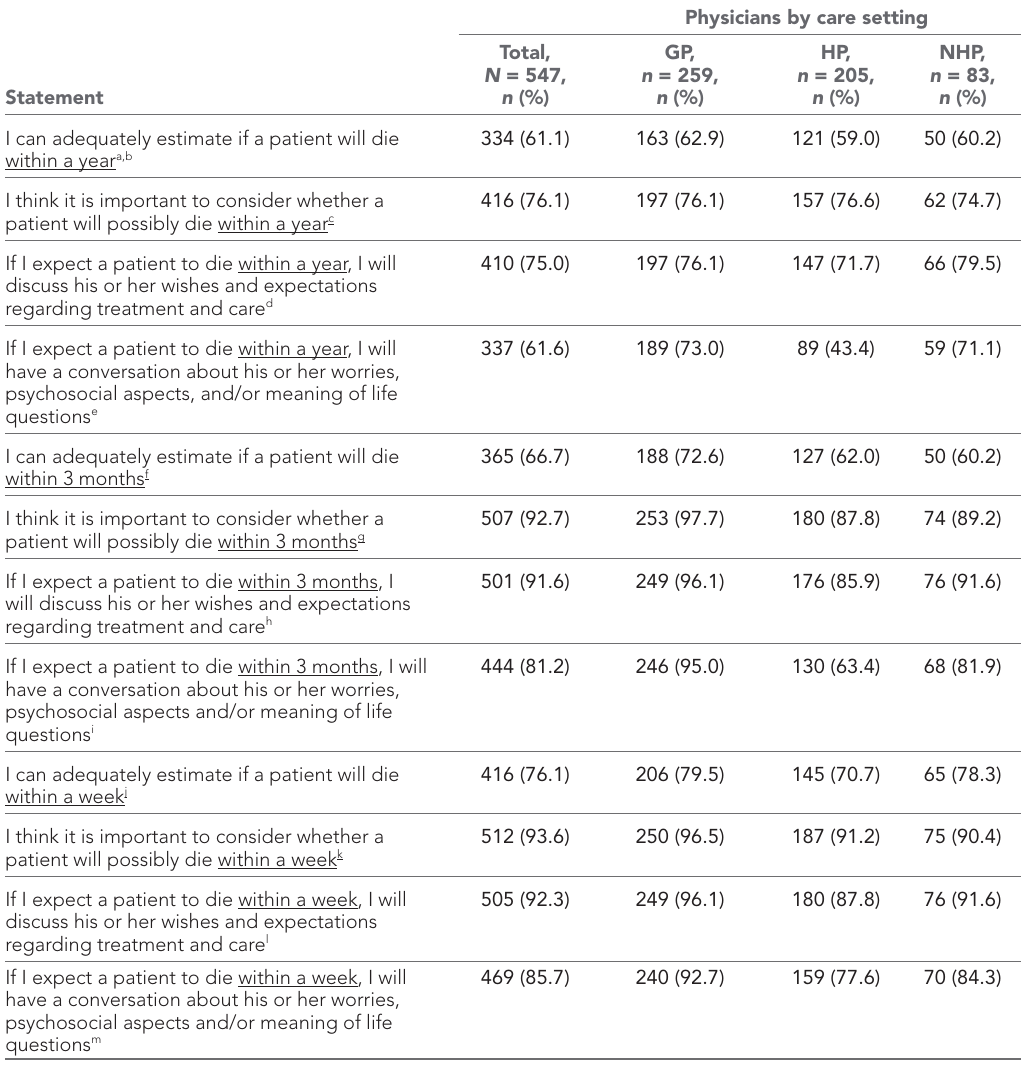
Table 2 Estimating and communicating prognosis with the